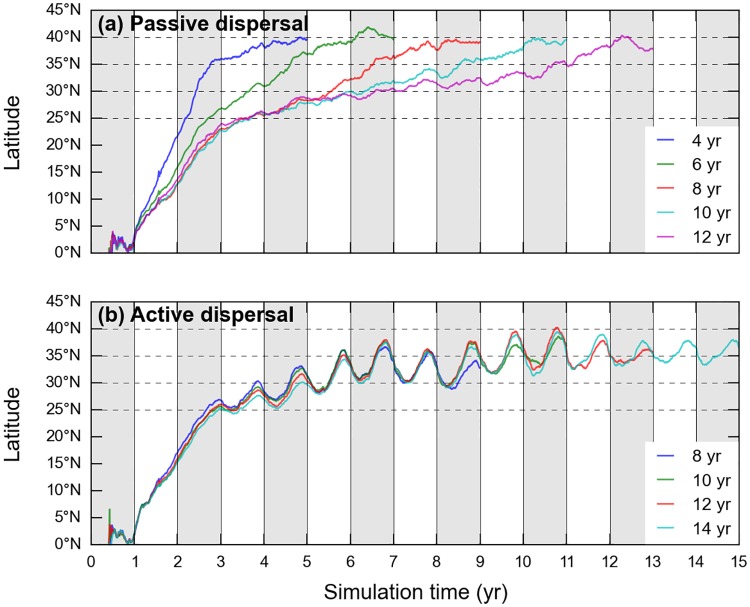
Mean latitude as a function of simulation time for groups of (a) passive and (b) active turtles with the same PCT.A group with a crossing time of N years is actually made of all turtles having a crossing time between N years– 6 months and N years + 6 months.